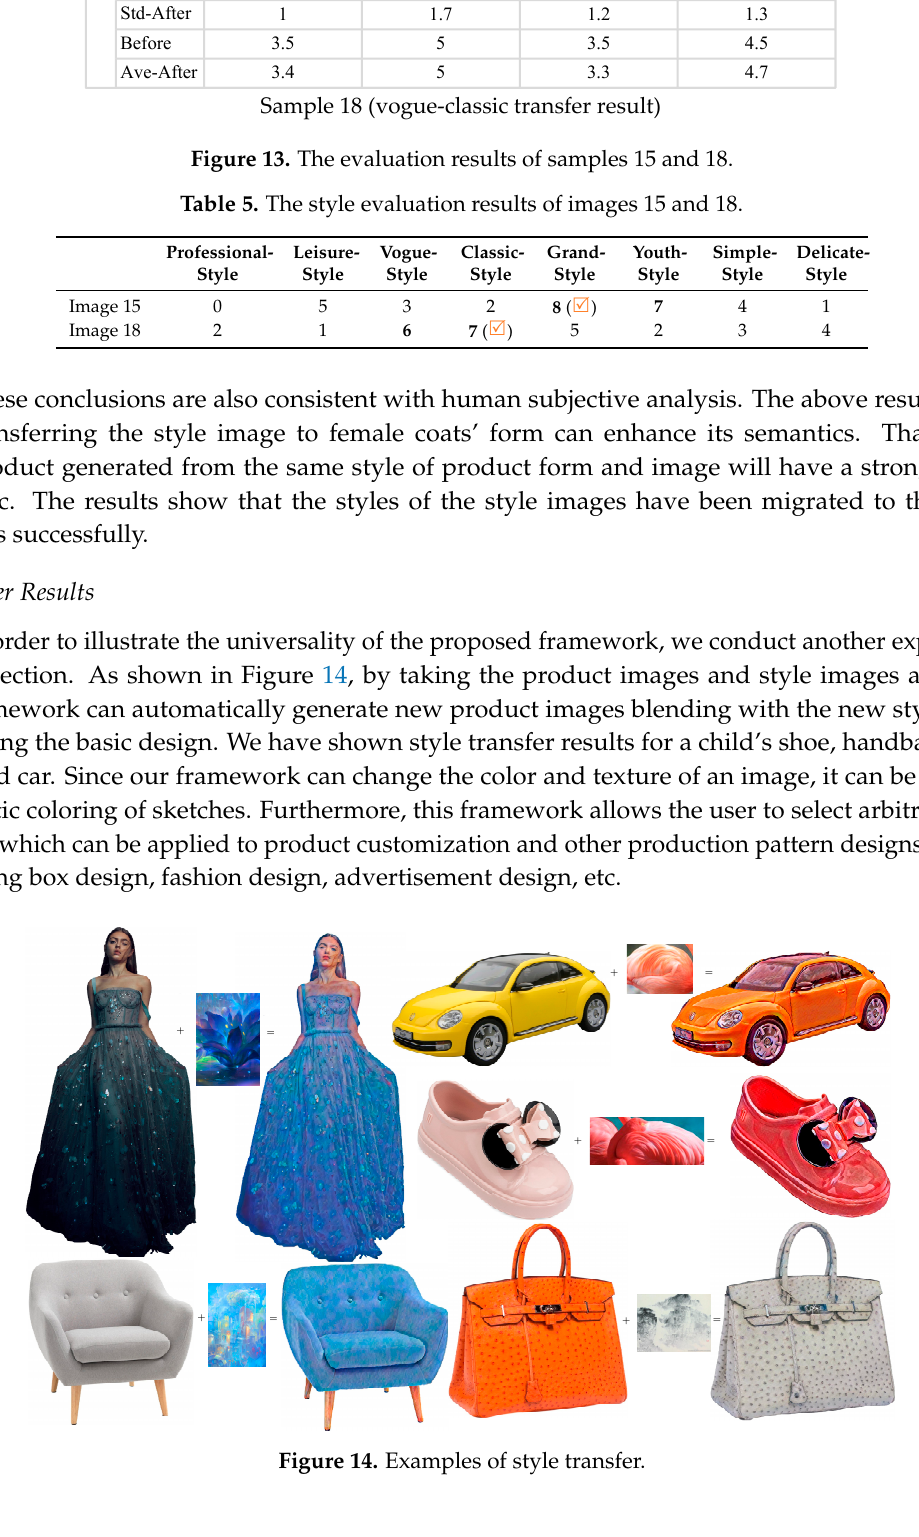
Figure 14. Examples of style transfer.